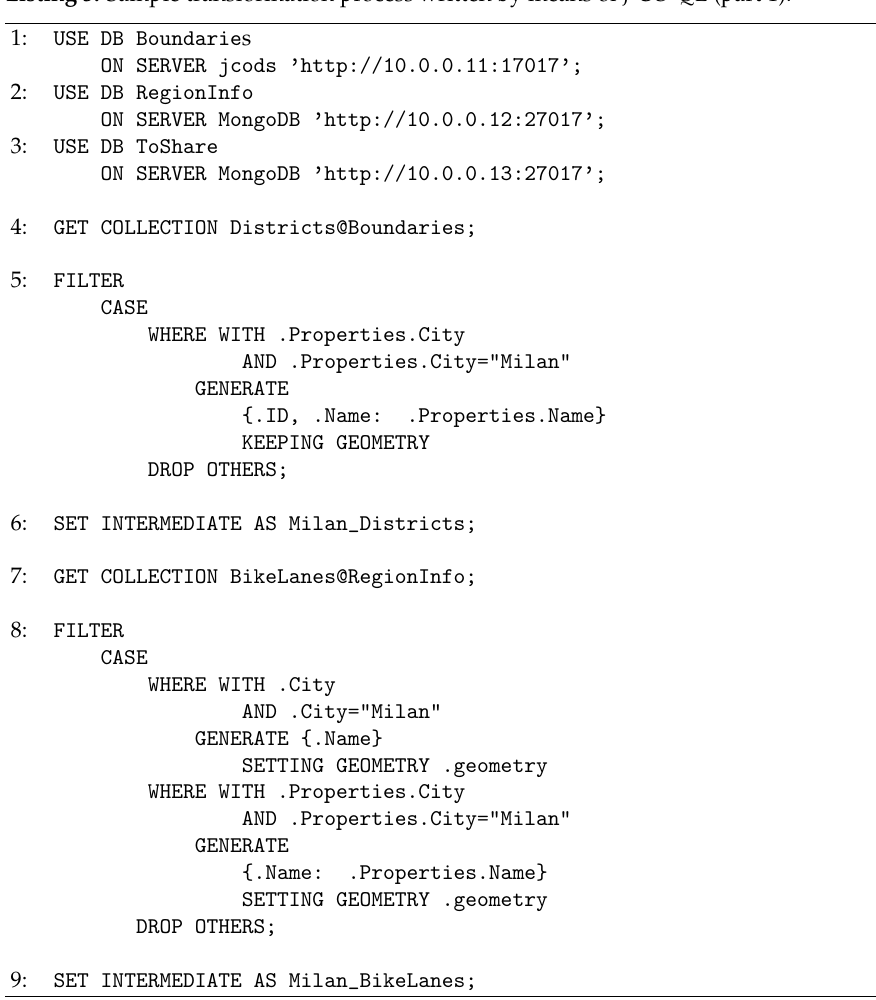
Figure 3. Execution trace for the sample transformation process written with J-CO-QL . Listing 3. Sample transformation process written by means of J-CO-QL (part